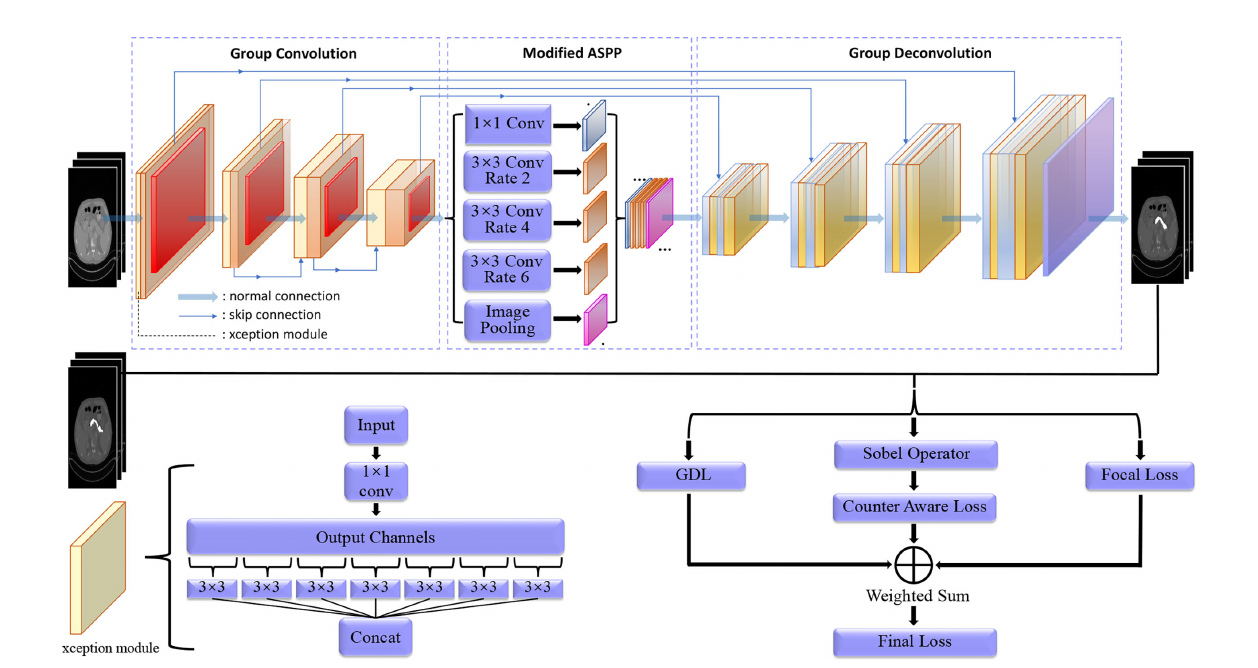
FIGURE 1 | An overview of our framework. When an original image is input, fi rst, it goes through an encoder with four downsampling blocks consisting of a group convolution (xception) and a max pooling, yielding a small feature map; then the small feature map goes through our modi fi ed ASPP module with dilated convolution to achieve multi-scale feature parallel extraction; and then the multi-scaled feature maps go through a decoder with group decovolution operations to achieve a feature map with the same shape of the original input image for pixel-wise classi fi cation. Finally, in the test process, the output feature map implies a segmentation for evaluation; in the training process, comparing the output feature map and the original input annotation to calculated the loss by the designed hybrid loss function for model